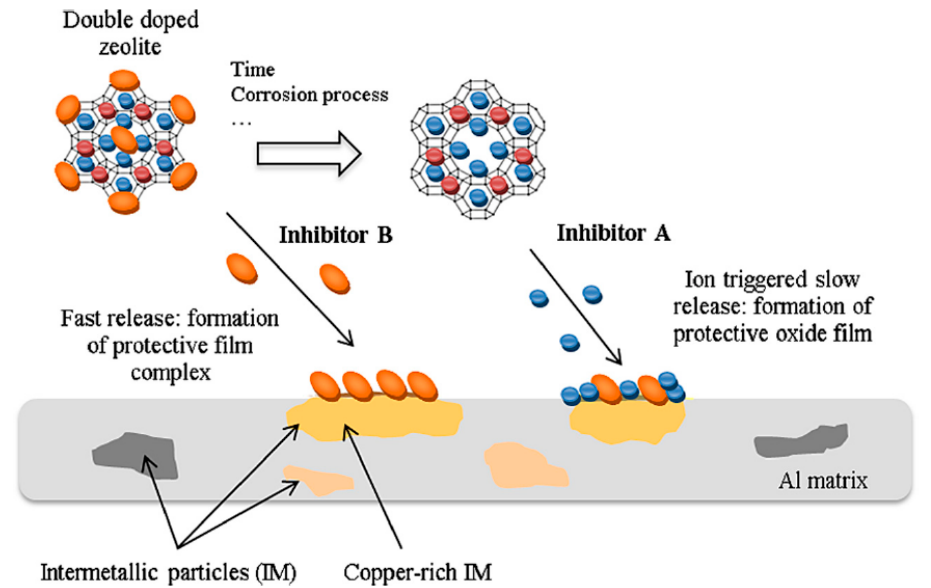
Figure 12. Scheme of the self-healing process of double doped zeolite on AA2024 metal substrate [98]. Reprinted with permission from Elsevier.